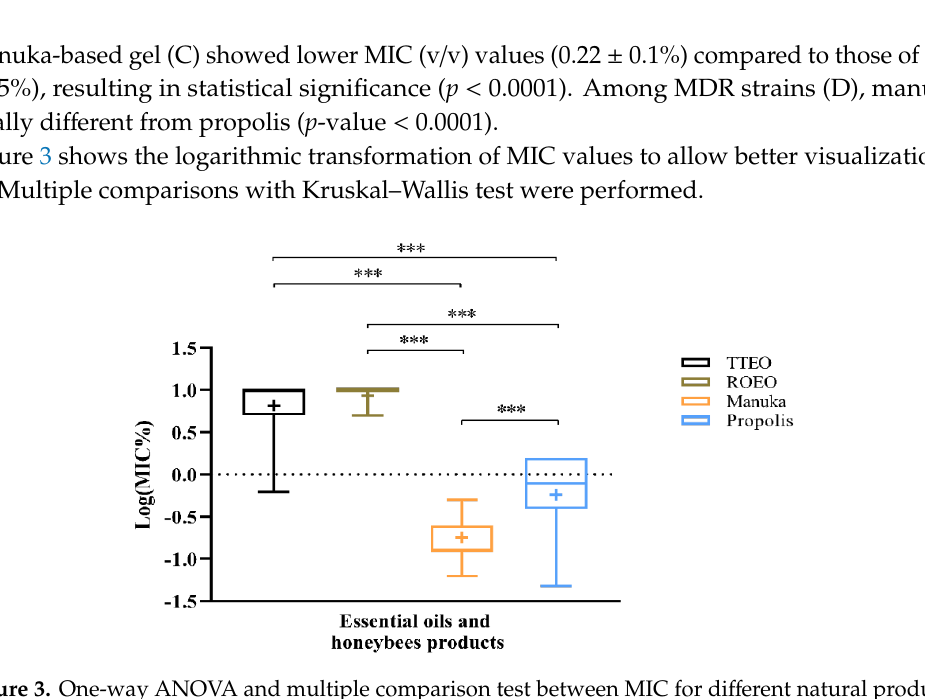
Figure 2. Minimum inhibitory concentration (MIC) values for all the natural products used. Box-plot was used to visualize the dataset, min to max are expressed by vertical lines, while median and mean are represented by horizontal and “+”, respectively; MIC are expressed as percentage volume per volume. t -test and one-way ANOVA followed by multiple comparison found no statistical significance between the two essential oils (EOs) ( A ) and among MDR and non-MDR strains ( B ). However, the same statistical tests found significative differences for honeybee products with lower MIC compared to those of EOs and a greater antibacterial ability. In particular, manuka-based gel ( C ) was statistically different compared to propolis even among MDR strains ( D ). (*** p-value < 0.001).